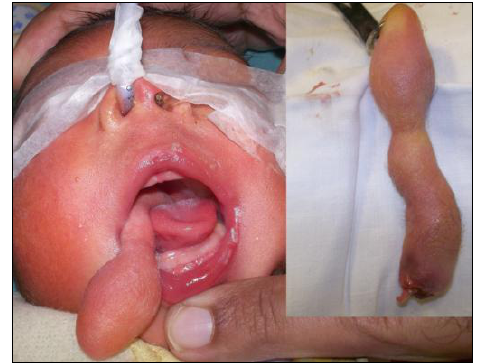
Figure 1: Figure showing congenital hairy polyp extruding from mouth. Inset shows excised